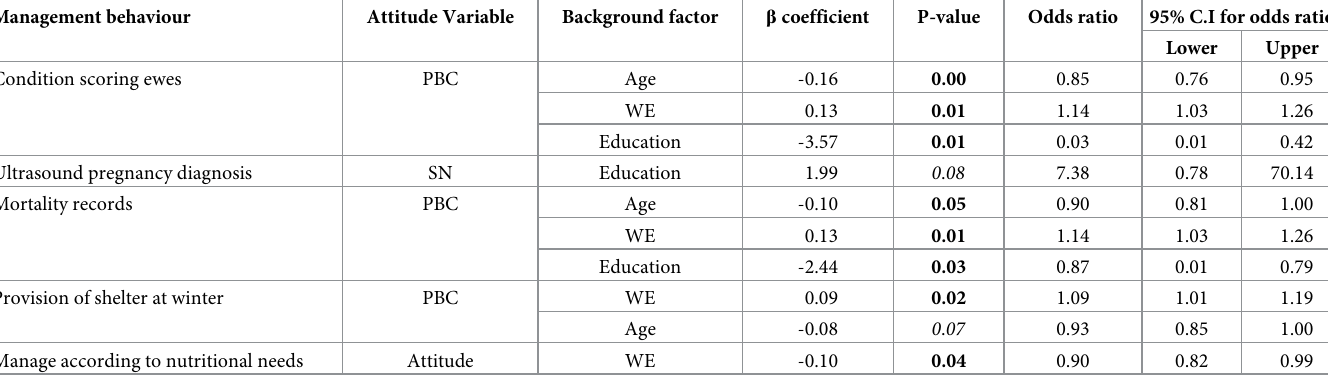
Table 8. Ordinal logistic regression analyses for farmer attitudes about management behaviour and farmers background factors (n = 32). Management